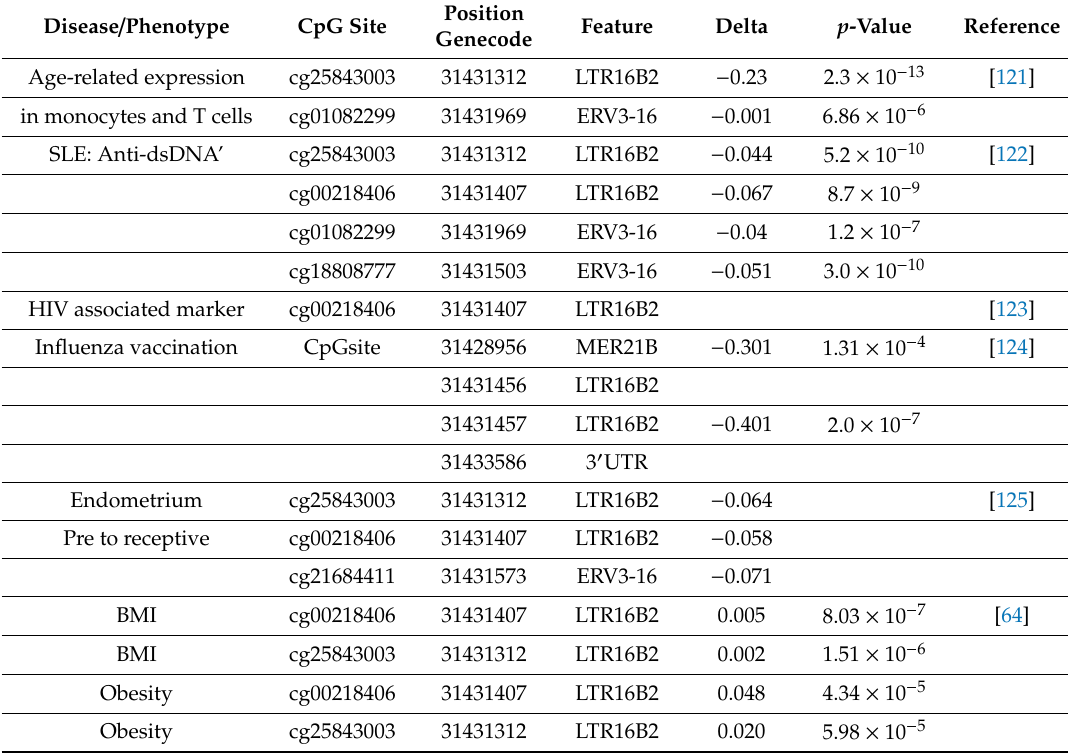
Table 4. Di ff erentially methylated positions of HCP5 (cid:48) in six recent studies. Disease /